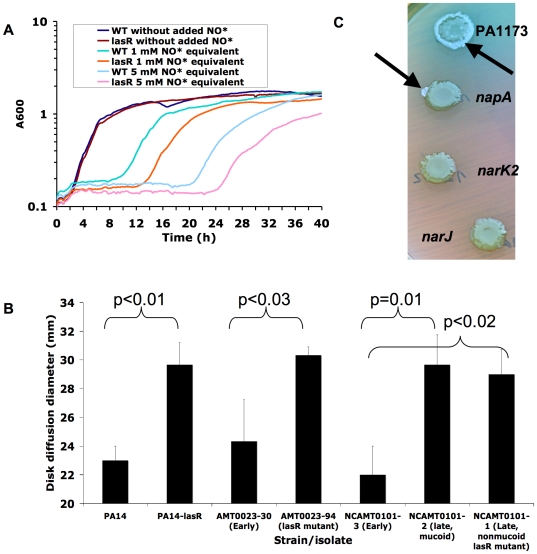
Mutation in lasR confers increased susceptibility to nitrosative stress, including acidified NO2
−.(A) Growth rate of PA14 versus PA14-lasR::Gm in LB in the presence and absence of two amounts of added NO· donor SPER-NO, transiently generating the indicated concentrations of NO·. Each result representative of at least two separate experiments. (B) Disk diffusion diameters of the indicated strains and isolates on LB agar buffered to pH 6.5, with disks containing 100 µmol of NaNO2, then incubated for 24 hours at 37°C under aerobic conditions. Average ±s.d. for triplicate experiments. Similar results were obtained with PA14ΔlasR, and complementation with a wild-type copy of lasR on a plasmid restored wild-type phenotypes to lasR mutants (not shown). (C) Spontaneous sectors displaying the lasR phenotype (metallic surface sheen and autolytic flattening, indicated by black arrows) arise during agar surface growth for 1 week of PA14-derived strains with transposon insertions in genes in the periplasmic NO3
− reductase gene cluster (top, genes PA1173 and napA) but not from those with insertion in genes in the membrane-bound NO3
− reductase gene cluster (bottom, genes narJ and narK2). Also visible around the lasR mutant sectors is the blue pigment pyocyanin, which is produced at higher levels by lasR mutant PA14 than by wild-type cells upon extended incubation [61]. Results representative of four separate experiments. Complementation with a wild-type copy of lasR on a plasmid restored wild-type phenotypes to lasR mutants isolated from sectors (not shown).